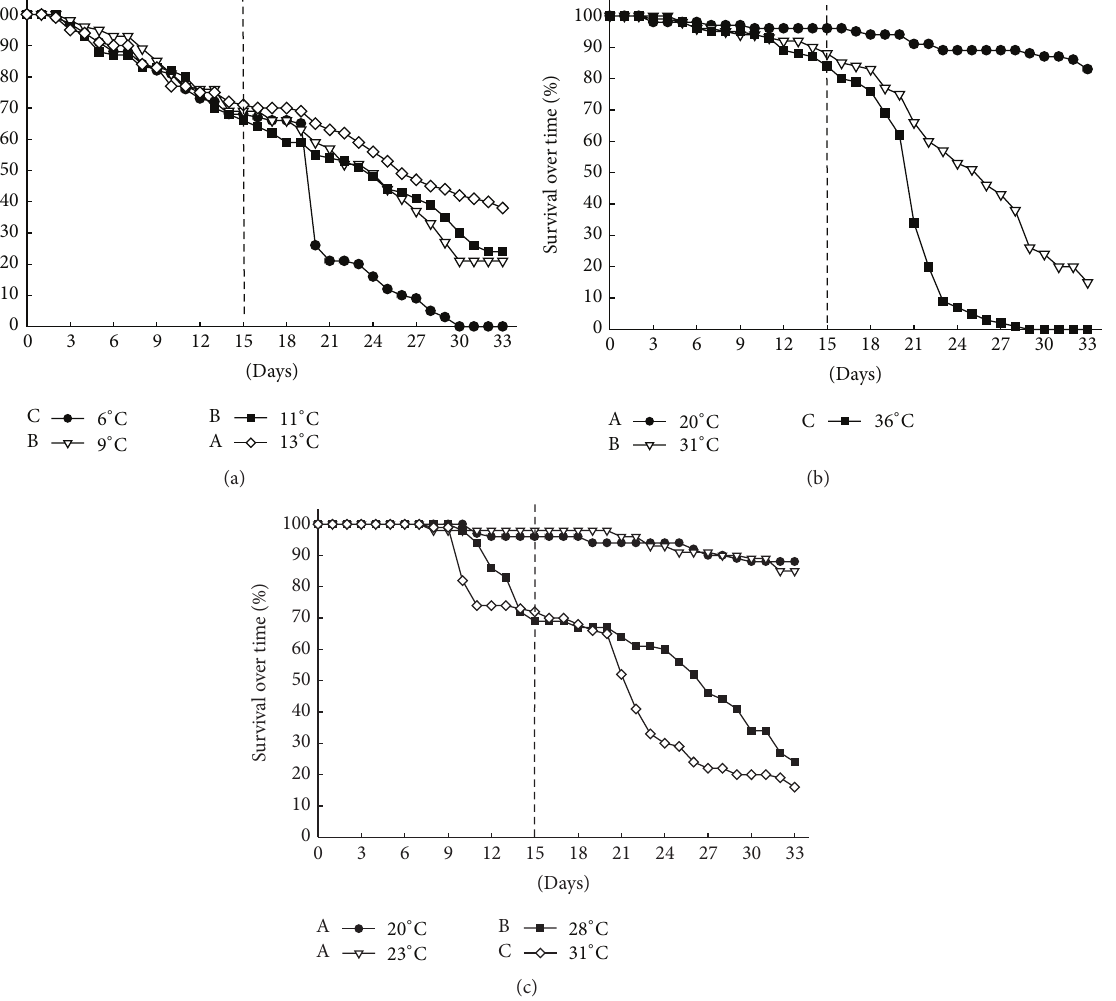
Figure 2: Survivorship curves of Mytella charruana for temperature experiments. Shell lengths: 20–54 mm. Capital letters correspond to the experimental treatments presented in Table 1(a). (a) Cold experiment (temperatures: 6, 9, 11, and 13 ∘ C); (b) warm experiment (temperatures: 20, 31, and 36 ∘ C); and (c) warm experiment (temperatures: 20, 23, 28, and 31 ∘ C). Upper case letters indicate significant differences in survivorship ( 𝑝 ≤ 0.05 ) among temperature treatments. Dotted lines show the end of the 15-day temperature adjustment